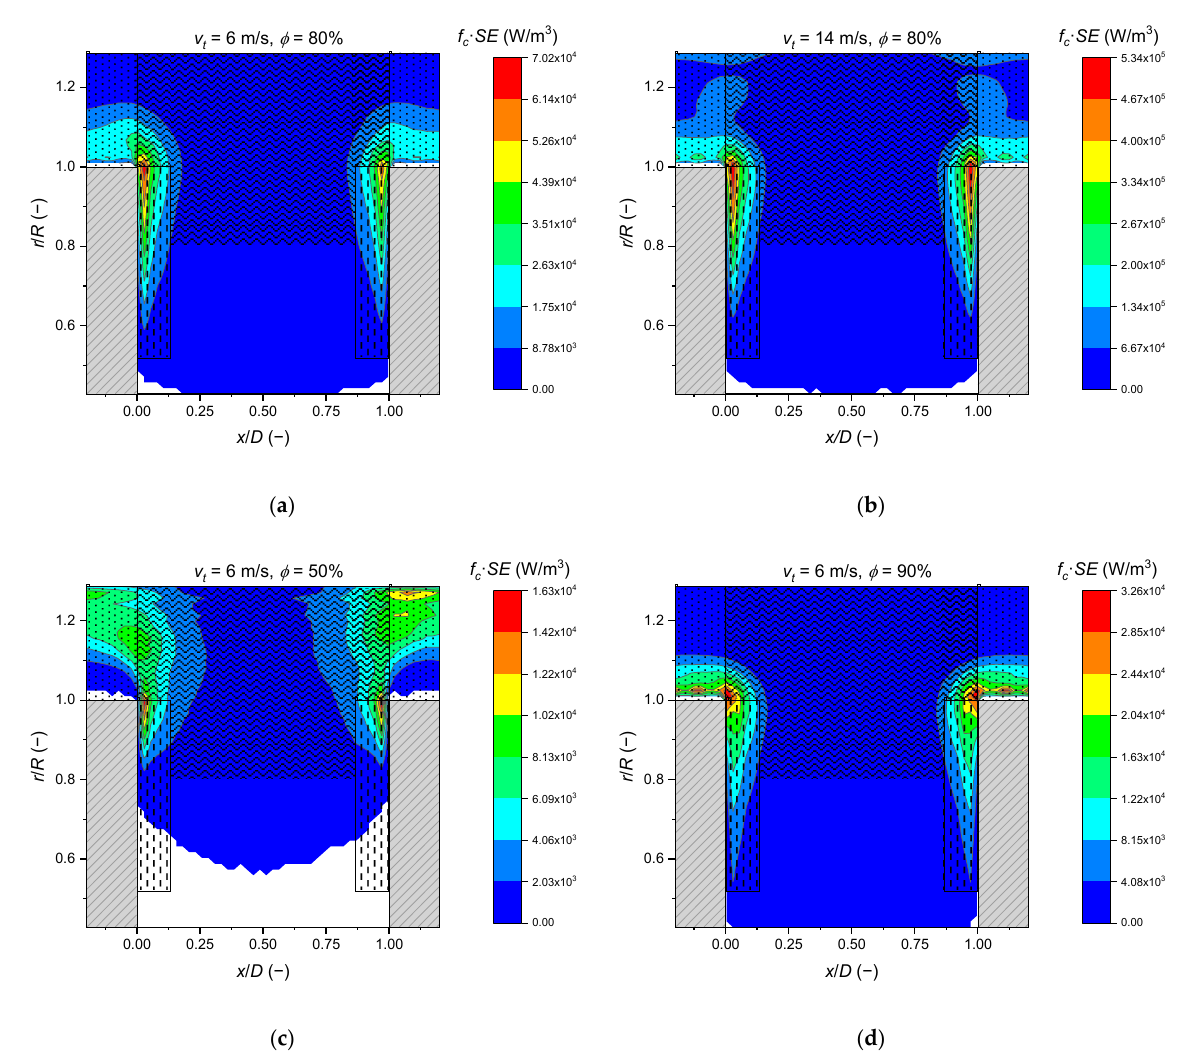
Figure 15. Radially averaged product of collision frequency f c and stress energy SE with the dimensions of the volumes marked as follows: V1, dots; V2, dashes; V3, saw-toothed. Each panel has its own scale. ( a ) Stirrer tip speed of 6 m/s and grinding media filling of 80%; ( b ) stirrer tip speed of 14 m/s and grinding media filling of 80%; ( c ) stirrer tip speed of 6 m/s and grinding media filling of 50%; ( d ) stirrer tip speed of 6 m/s and grinding media filling of 50%.